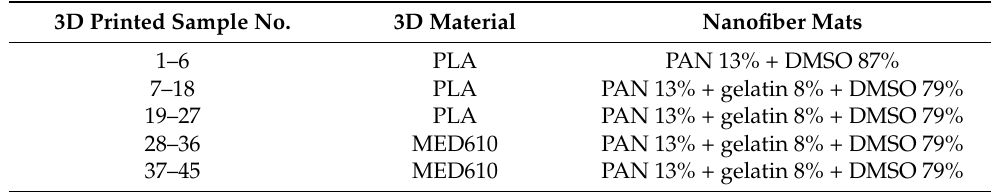
Table 2. Overview of the 3D printed samples. 3D Printed Sample No.